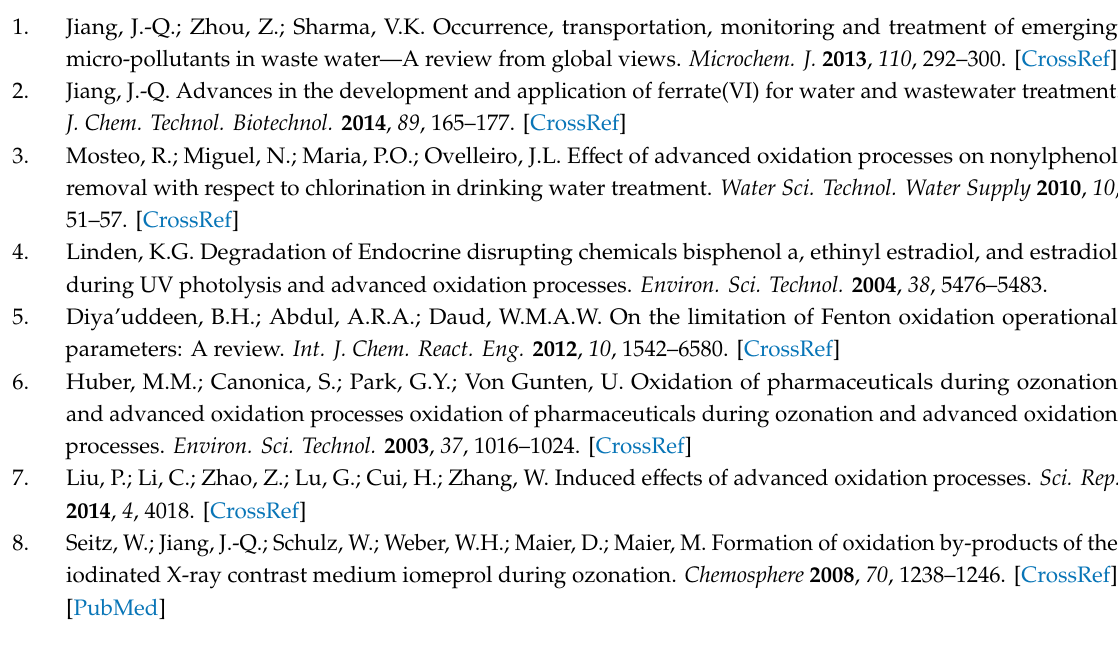
Figure S1. Micro-pollutants (MPs) degradation at optimal experimental conditions. Figure S2. Regression plot of actual vs predicted SN ratio obtained after the Taguchi analysis for the (a) FeSO 4 treatment (R2 = 0.956) and (b) Fe treatment (R2 = 0.996). Table S1. Taguchi array L16 experimental